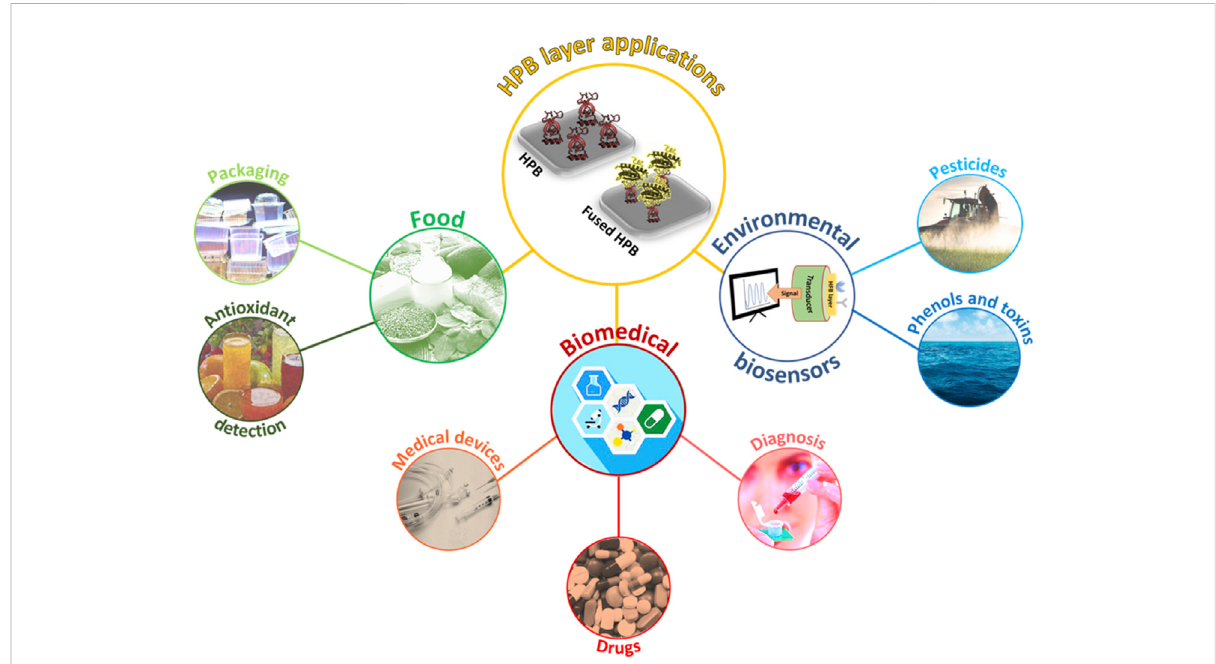
FIGURE 1 Schematic representation of HPB layer exploitation in different application fi